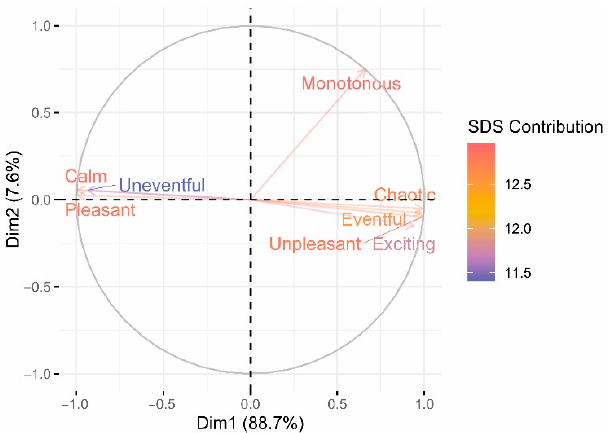
Figure 8. Component scores of the 8 semantic differential scales under study. Red to blue scales were used to represent the contribution of each variable to the model.